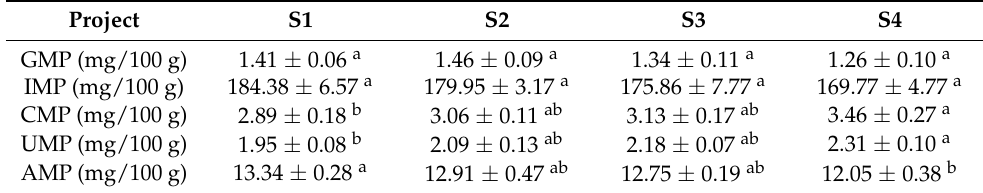
Table 4. Effects of different cooling rates on the nucleotide content of crucian carp